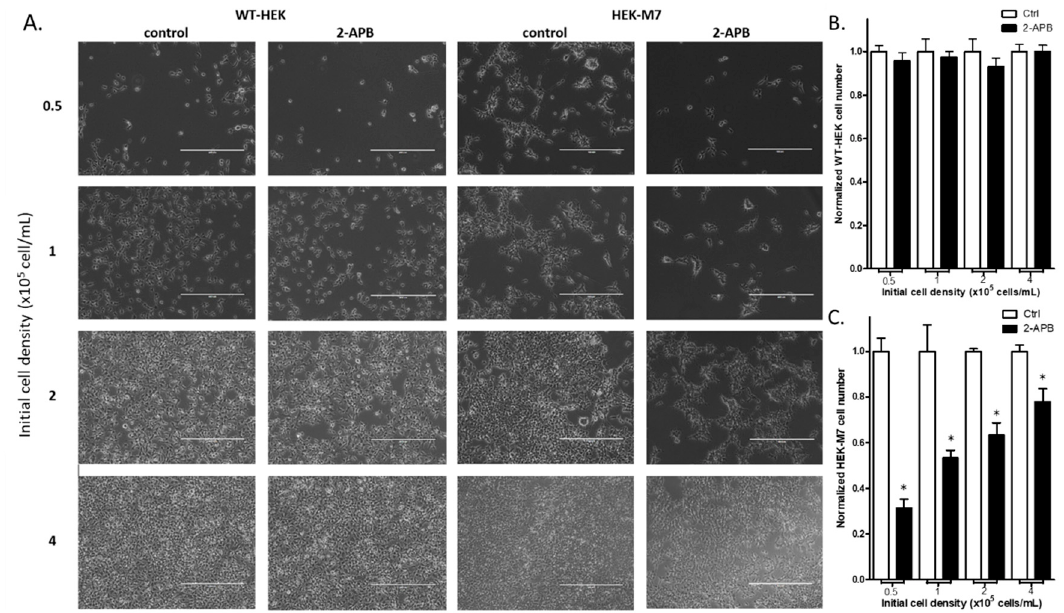
Figure 3. Suppression of cell proliferation in WT-HEK and HEK-M7 by 2-APB. Cells were planted in different cell densities and were treated with 200 µM 2-APB for 24 h. ( A ) Representative images of the cells. The scale bar corresponds to 400 µM. ( B , C ) Cell counting assay showed that 2-APB did not change the cell number in WT-HEK, whereas in HEK-M7, there was a density-dependent decrease in cell number. Significant differences ( p < 0.05) from the control are indicated by “*”.